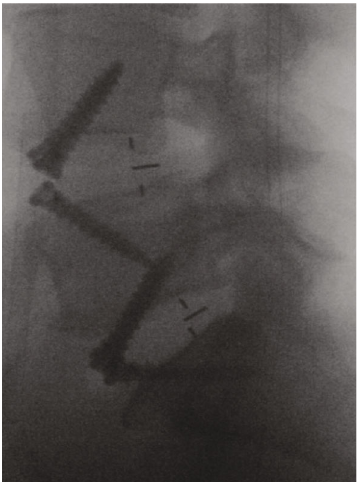
Figure 3: Intraoperative sagittal X-ray demonstrating anterior interbody grafts.